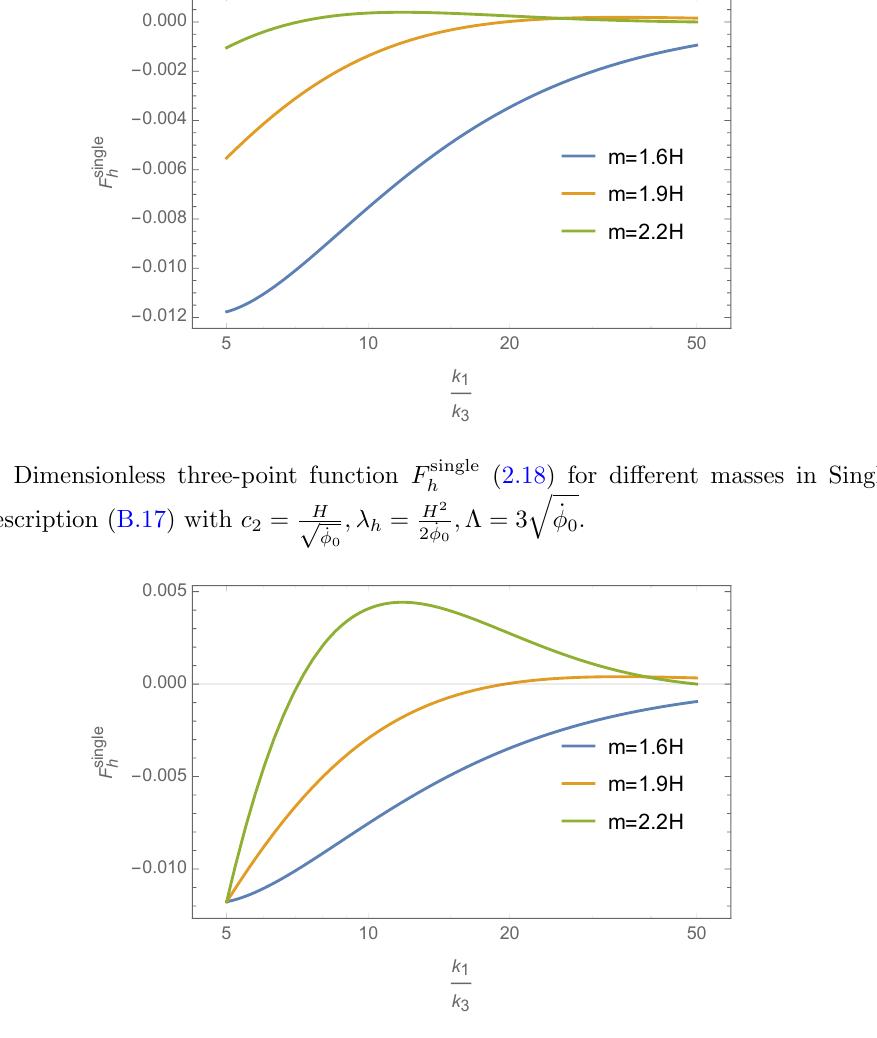
Figure 8 . Shape sensitivity of F single to m h . We have chosen three plausible sets of parameters for h which F single agree at the (cid:12)ducial ratio k 1 = 5. This illustrates our ability to discriminate among h k 3 di(cid:11)erent